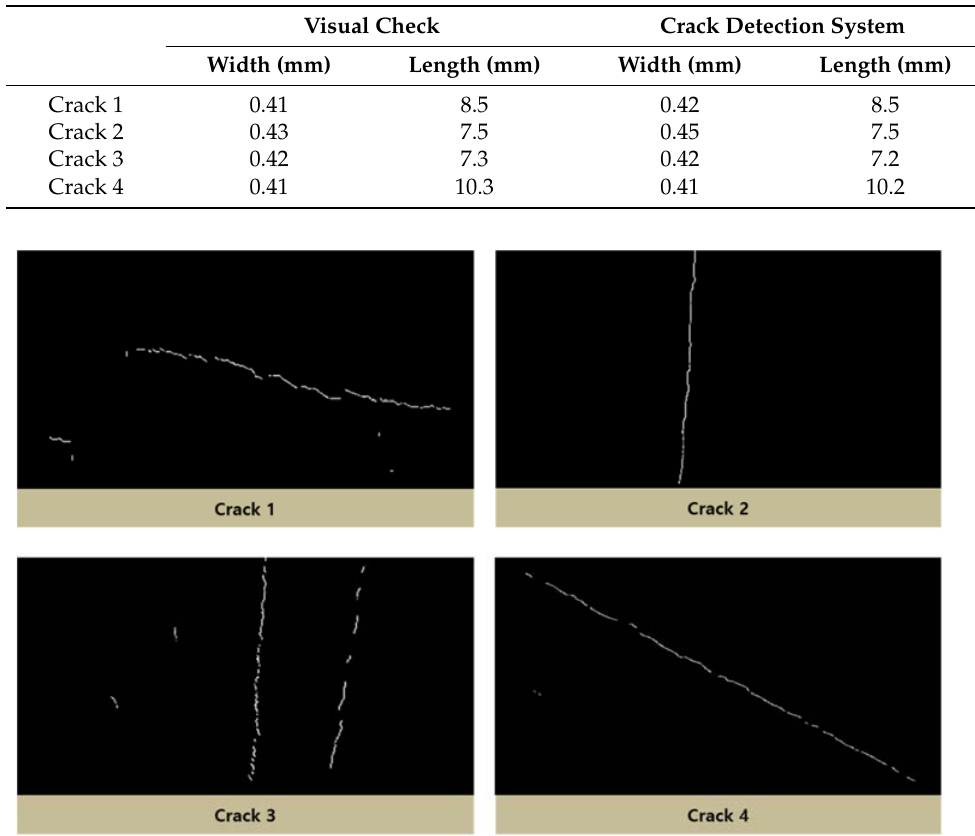
Figure 15. Images of the crack detection result.